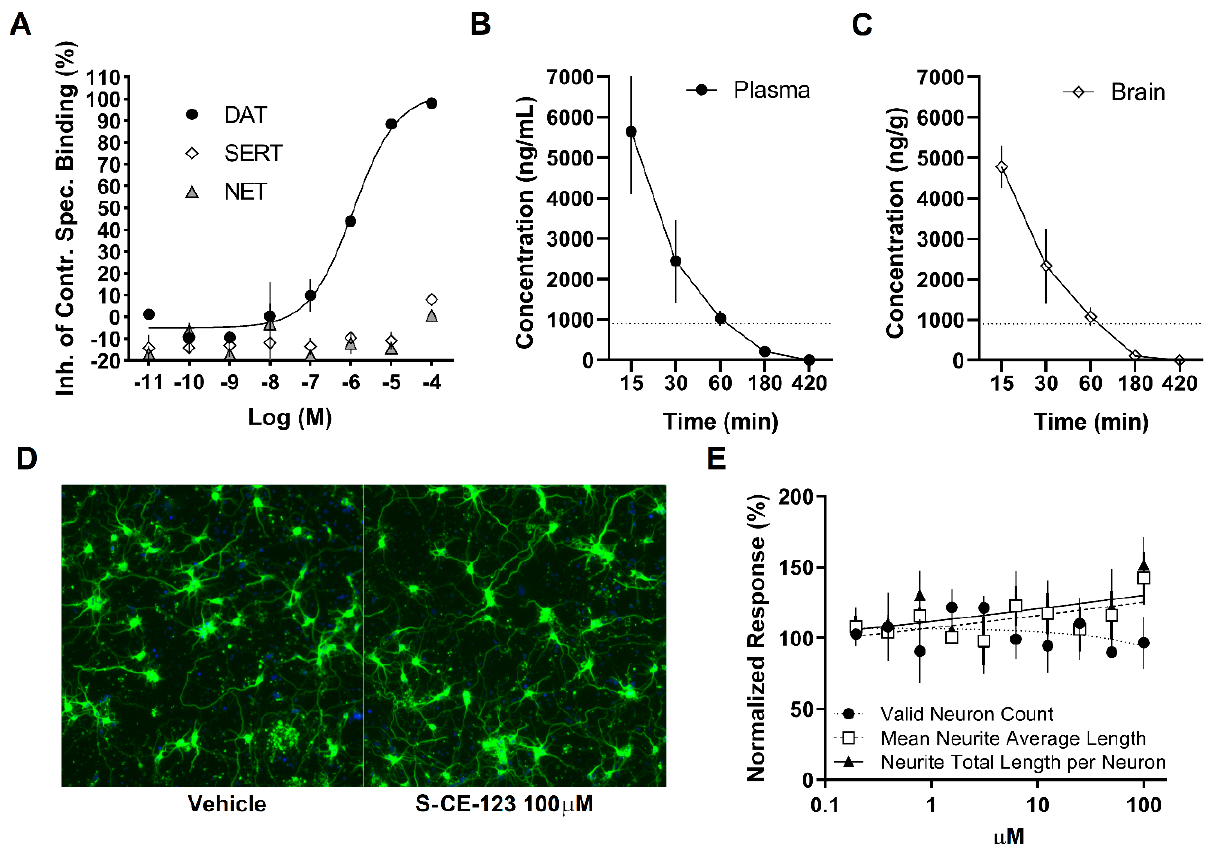
Figure 1. ( A ) S-CE-123 competes for the binding of radioligand specific to the hDAT with IC50 = 1.1E-06 M and K i = 6.1E-07 M. ( B ) The plasma concentrations of S-CE-123 after a single i.p. administration at 10 mg/kg. ( C ) The brain concentrations of S-CE-123 after a single i.p. administration at 10 mg/kg. ( D , E ) S-CE-123 did not show neurotoxic effect on cell viability or neurite outgrowth of cortical neurons in vitro. Data are presented as a mean ± SEM, n = 3.